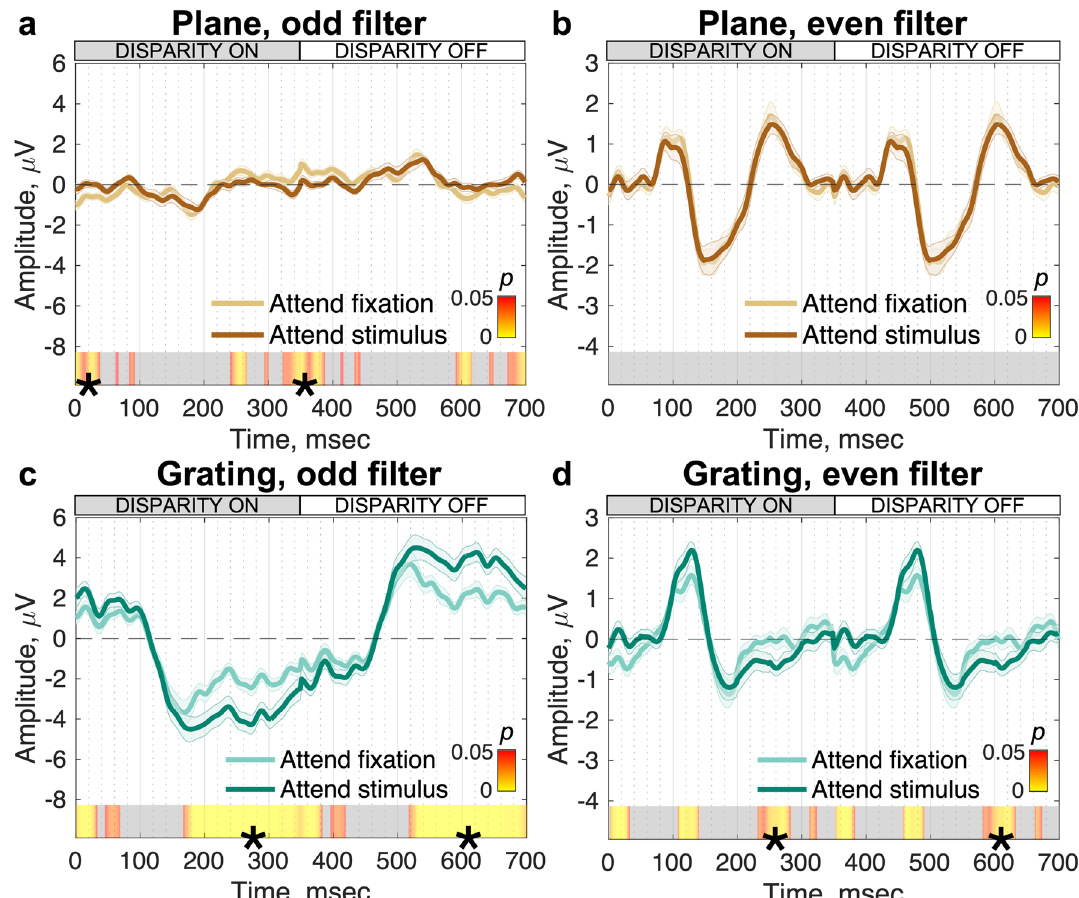
Figure 5. Task effects on EEG responses to disparity stimuli under different Fourier filtering regimes that highlight sustained vs. transient response components (N = 20). ( a ) and ( b ) show responses to the plane stimulus (absolute disparity); c and d show responses to the grating stimulus (relative and local absolute disparities). The “Odd” filter (left column) preserves the odd harmonics of the fundamental frequency (1F1, 3F1, 5F1, etc.) and highlights sustained response components driven by the amplitude of the 1F1 response. Where this signal is present ( c ), there is a significant effect of task. The “Even” filter (right column) preserves the even harmonics of the fundamental frequency (2F1, 4F1, 6F1, etc.) and reveals transient, temporally symmetric responses at disparity on- and off-sets. There is no task effect for the plane stimulus ( b ) and there are some small effects for the grating ( d ), but these are localized outside the main positive/negative deflections that demarcate the stimulus transitions. Data are group-level averages weighted by RC1, errors are ± 1 SEM and the color bars indicate significance (paired-samples t -test). Segments marked with (*) indicate sequential, significant time points that pass the threshold for run-length correction and grey =